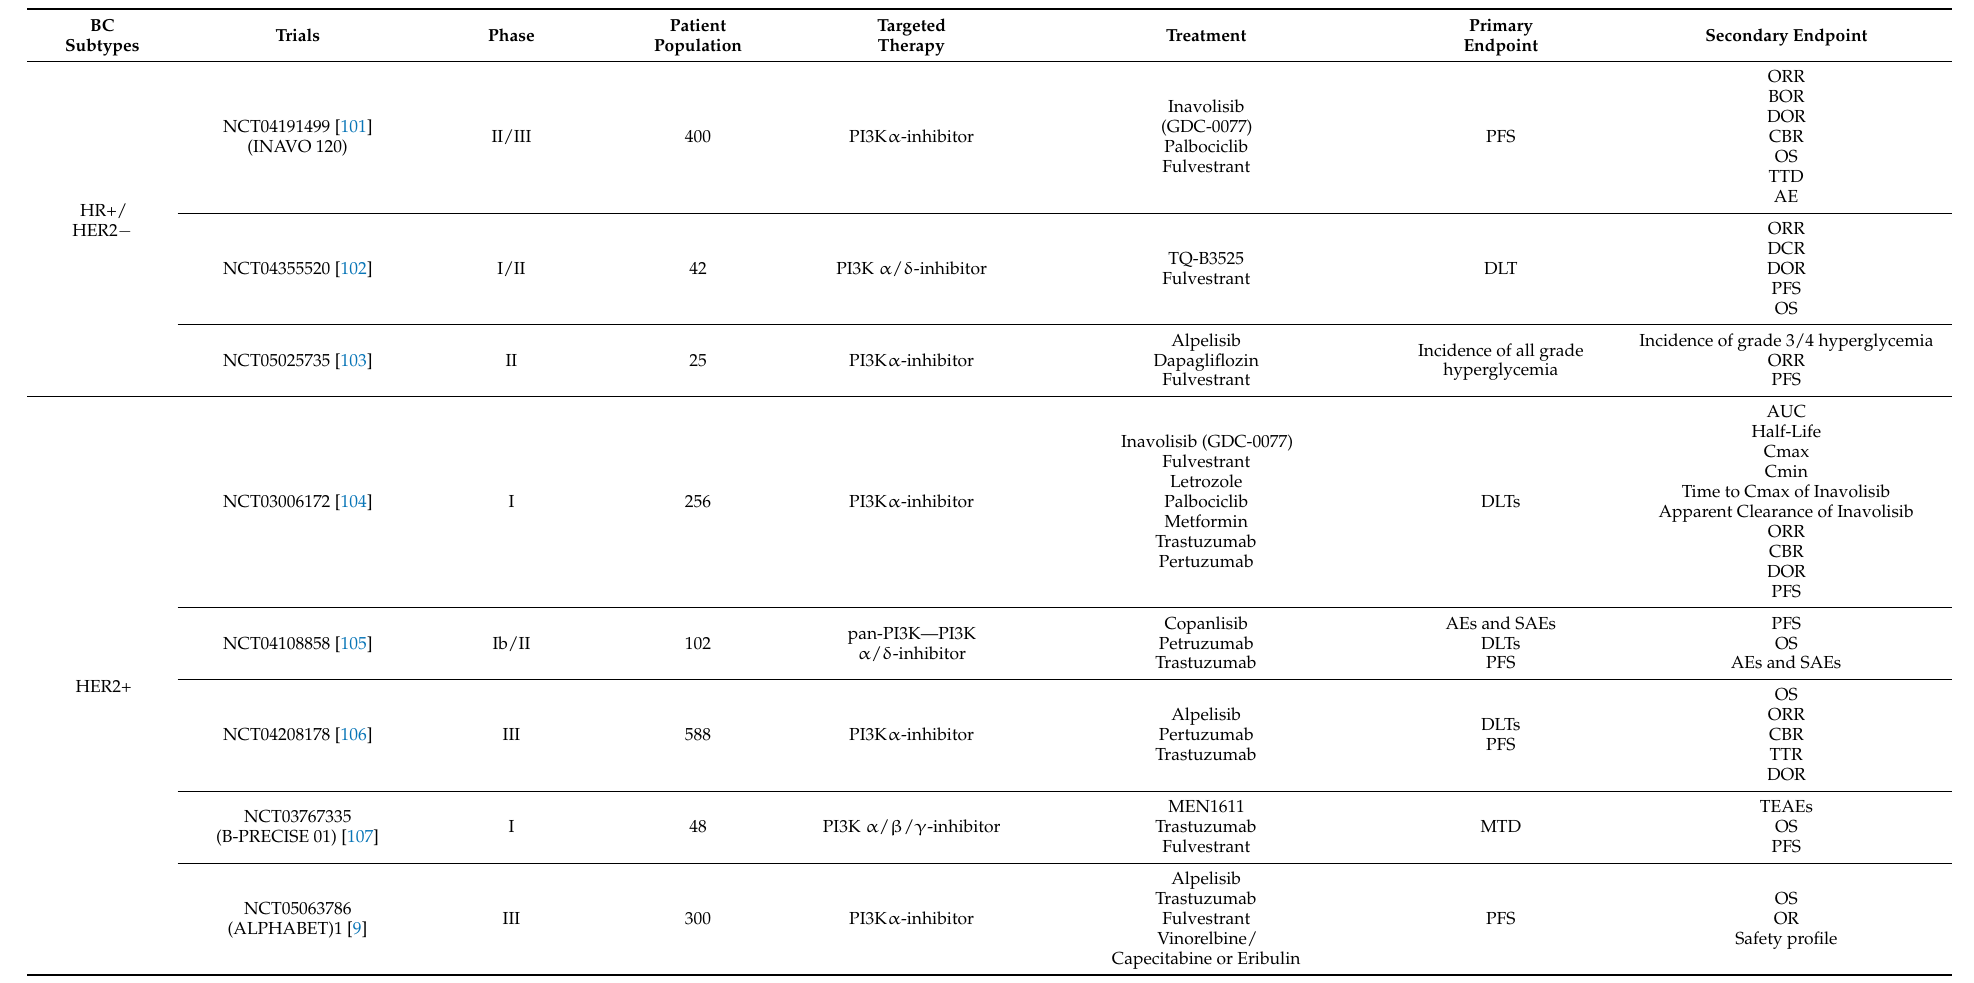
Table 3. Summary of ongoing phases I–III trials with PI3K-inhibitors in metastatic breast cancer according to different molecular